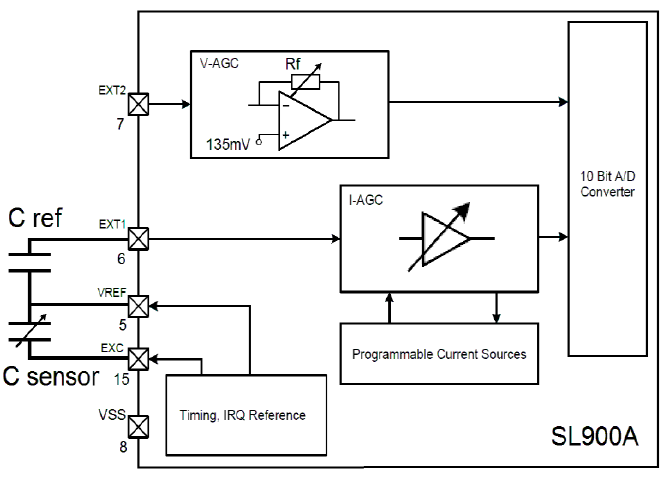
Figure 6. Block diagram of External Sensor Interface of SL900A. For a capacitive sensor ( C sensor ) a reference capacitor ( C ref ) must be inserted in Ext1 pin.